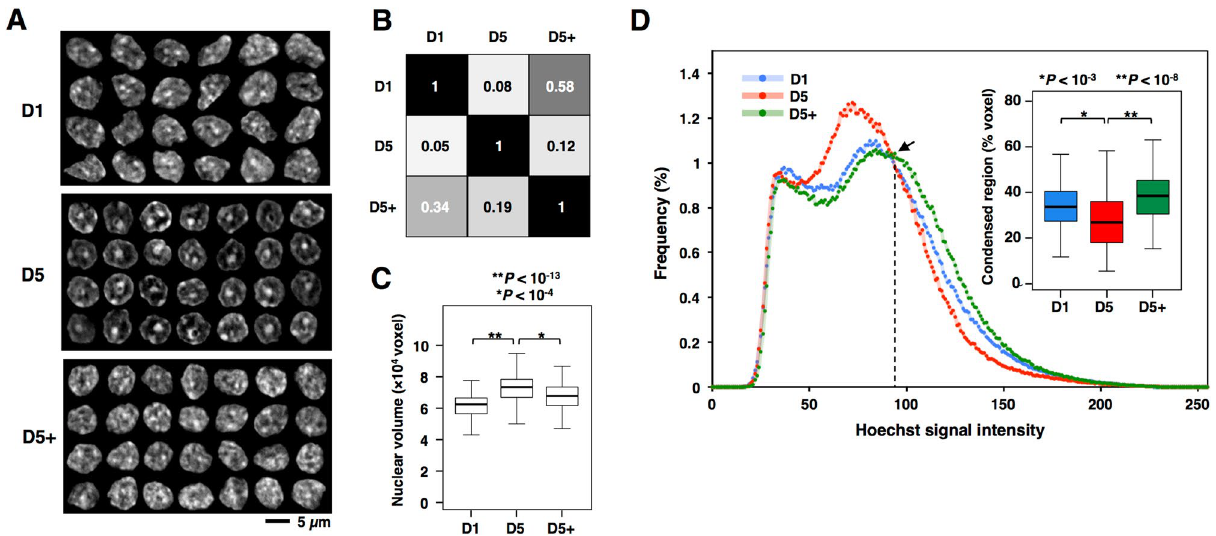
Figure 5. Morphological observations implicating topo IIβ-dependent chromatin opening during CGN differentiation. ( A ) Changes of global chromatin structure. Nuclear DNA in fixed cells was stained with Hoechst 33,342 at the culture days indicated. Nuclear images (z-stack with maximal diameter) were collected and arranged in 3 panels. ( B ) Similarity analysis by a machine-learning program, Wndchrm. Eighty images each was used for learning. Similarity indexes (between 0 and 1) shown are average of 4 trials. ( C ) Measurement of nuclear volume. Horizontal bars in boxplot indicate median values and p-values are from Mann–Whitney U test. ( D ) Degree of chromatin condensation as estimated from DNA staining intensities. The isosbestic point marked by arrow indicates the border between condensed and dispersed chromatin regions. Percentages of condensed region (right side of the curve) were box-plotted